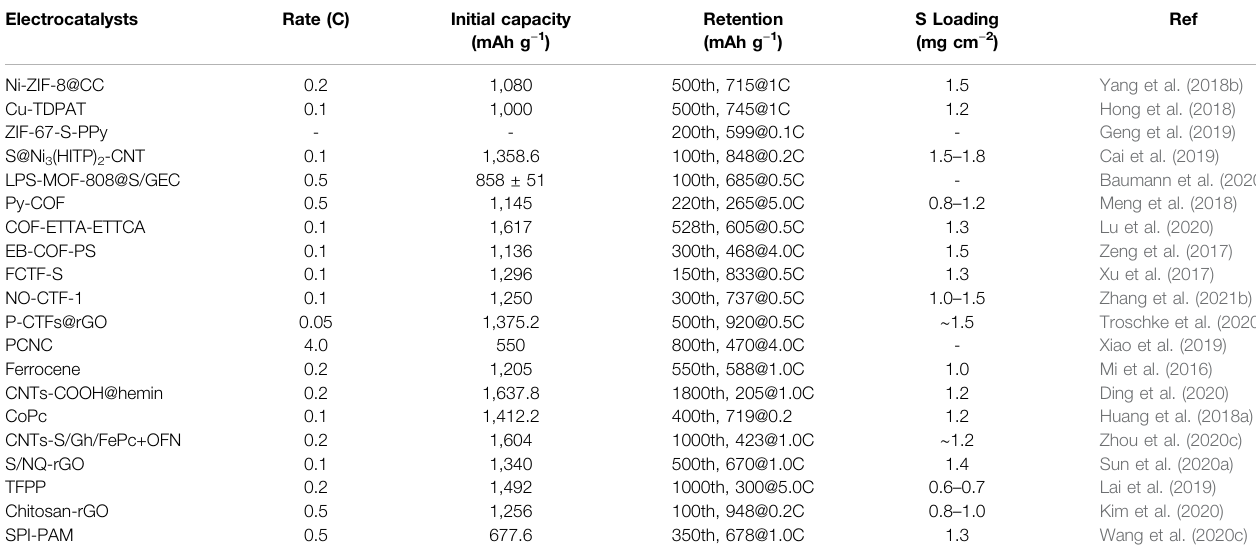
TABLE 1 | Some related reports on organic electrocatalytic cathodes for Li − S